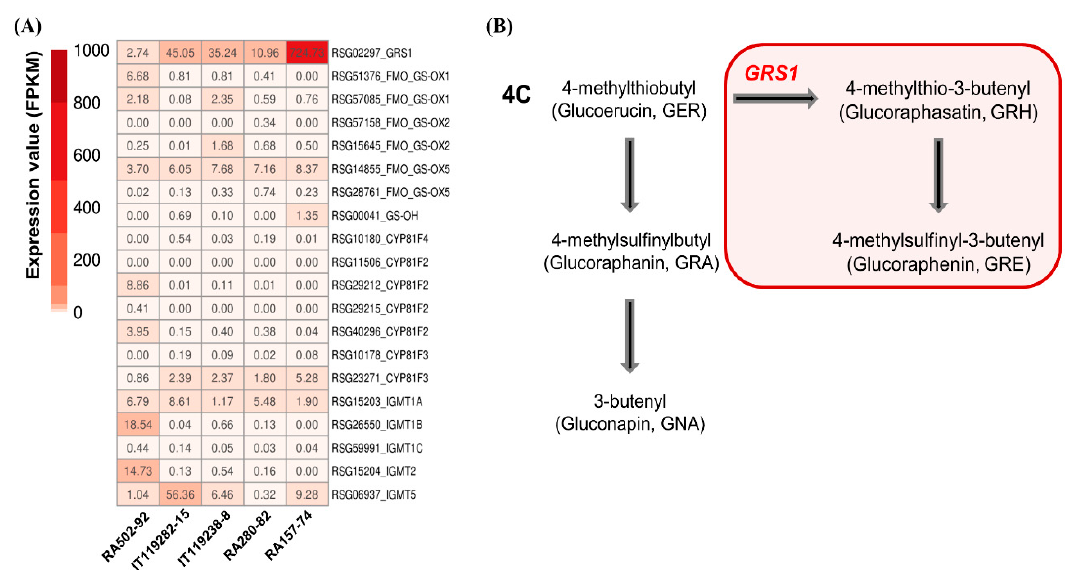
Figure 5. Heat map analysis of genes involved in side chain modification during GSL biosynthesis and the GRH modification step. ( A ) Heat map analysis and FPKM value of genes involved in side chain modification. ( B ) Side chain modification step in common 4-carbon aliphatic GSLs in the Brassicaceae family. The red box indicates the specific side chain modification for GRH production in radish. GRS1 encodes glucoraphasatin synthase 1.